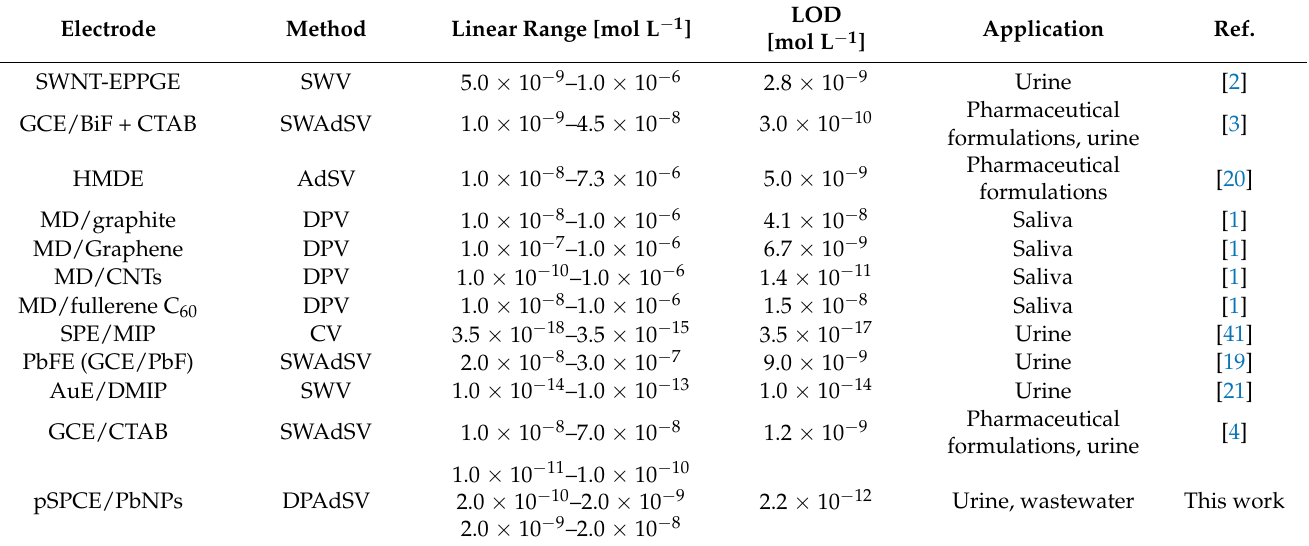
Table 1. Comparison of techniques for analysis of